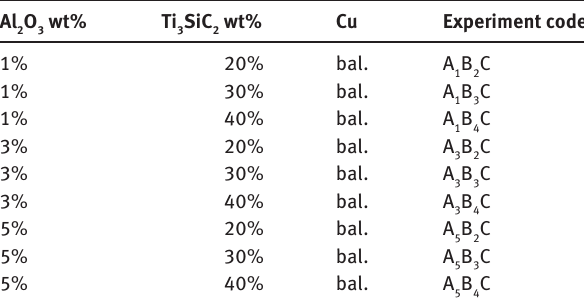
Table 1: Composition of pantograph slide with different fraction of SiC , copper and nano-Al Ti 3 2 Al O wt% 2 3